Question: In one sentence, what is this figure communicating?
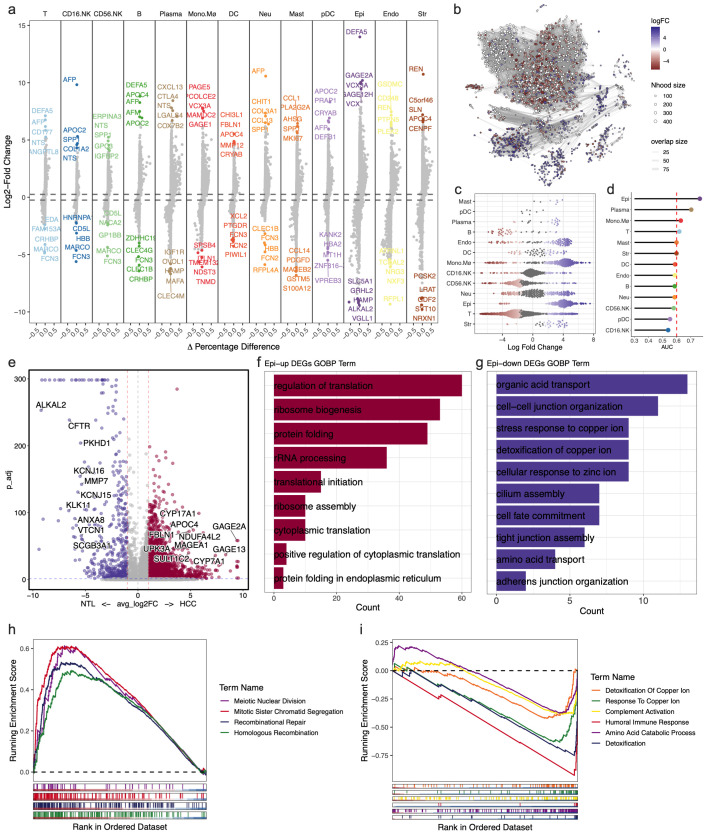
Answer: Multi-dimensional analysis reveals transcriptomic remodeling and functional changes in cell types in HCC. (A) Differentially expressed genes (DEGs) between tumor and normal groups across cell types, were analyzed using the Wilcoxon rank-sum test. (B) Differential abundance analysis using the Milo k-nearest neighbor (kNN) algorithm. (C) Statistical results of the Milo kNN differential abundance analysis. (D) Augur analysis framework assessing the degree of transcriptomic perturbation in each cell subtype between biological states. (E) Volcano plot of DEGs in epithelial cells between tumor and normal groups. (F) GO functional enrichment analysis of DEGs in tumor epithelial cells. (G) GO functional enrichment analysis of DEGs in normal epithelial cells. (H) GSEA pathway enrichment analysis of DEGs in tumor epithelial cells, showing representative signaling pathways. (I) GSEA pathway enrichment analysis of DEGs in normal epithelial cells.